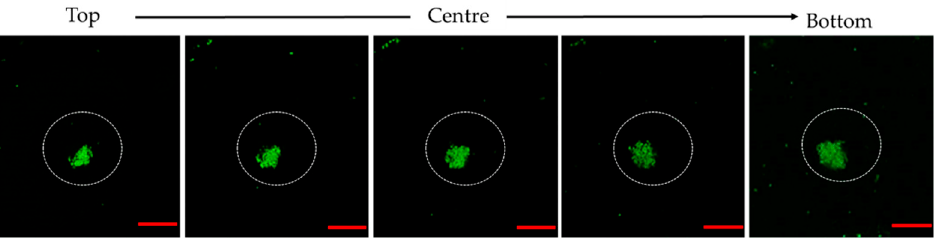
Figure 7. Cross ‐ sectional images of E. coli clustering cells taken using a confocal microscope at day one of storage. Scale bar: 25 μ m.